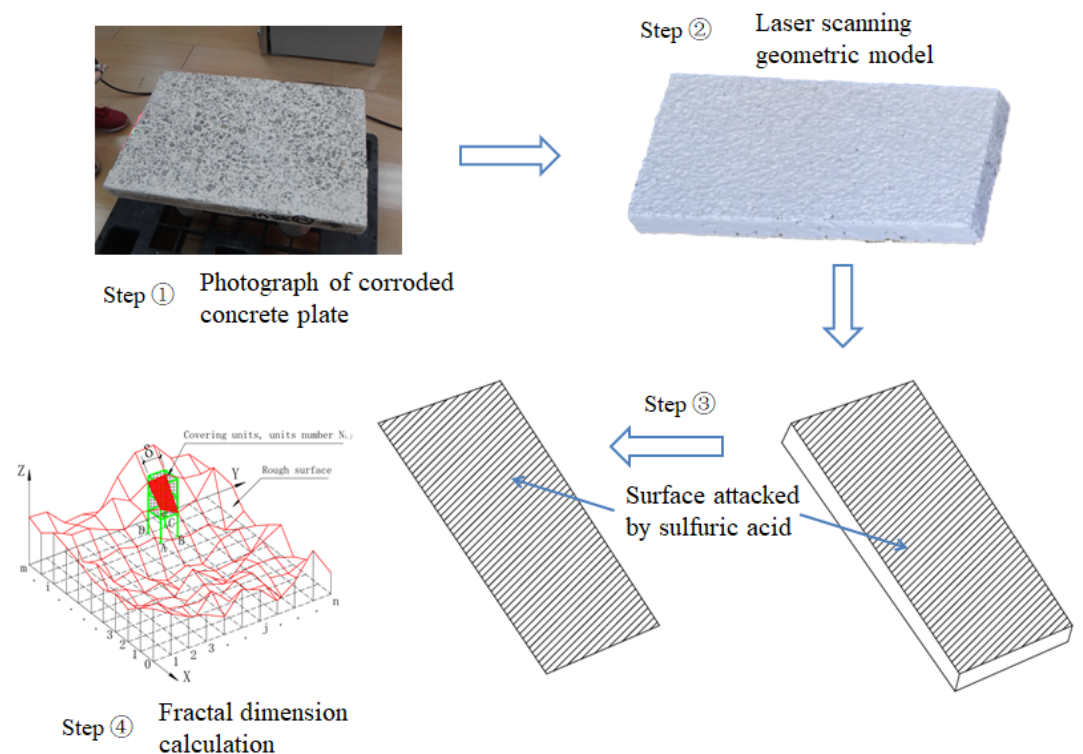
Figure 8. Four steps to obtain the fractal dimension of concrete plates.